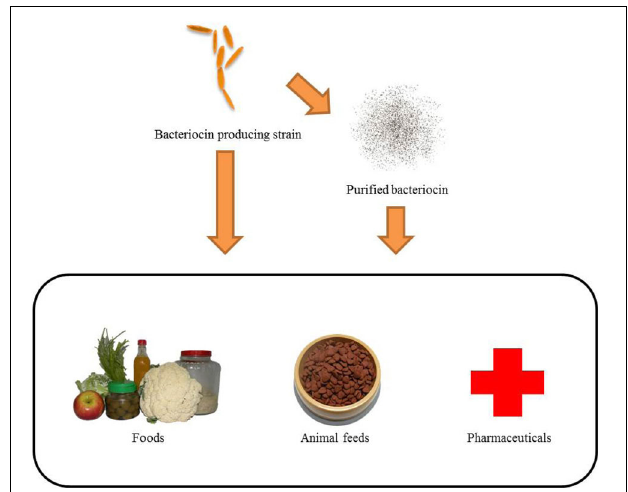
FIGURE 2 | Bacteriocin-producing strains and purified bacteriocins can be applied to food, animals, and medicine. If bacteriocin-producing strains are applied through start culture or co-culture in food, it can extend the preservation of food. Probiotics produced by bacteriocins can balance the bacteria in the digestive tract to reduce gastrointestinal diseases. Purified bacteriocins can be added directly to foods as a natural preservative. Bacteriocins can be added to animal feed as an anti-pathogen additive to protect livestock against pathogen damage. The bacteriocins used in medicine can improve the quality of human life. Bacteriocins have the potential to replace antibiotics as an antibacterial drug, and are a novel anti-cancer